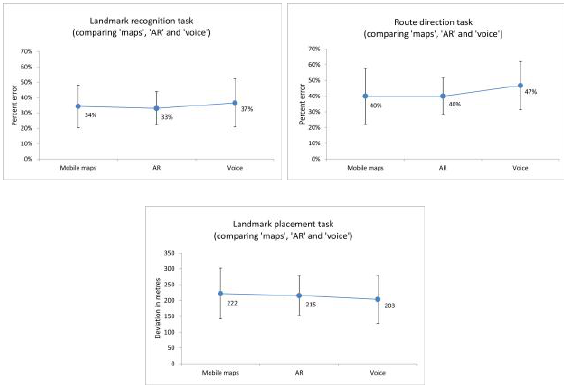
Figure 3. Comparison of the influence of mobile maps, AR, and voice on spatial knowledge acquisition: the landmark recognition task (mean percentage